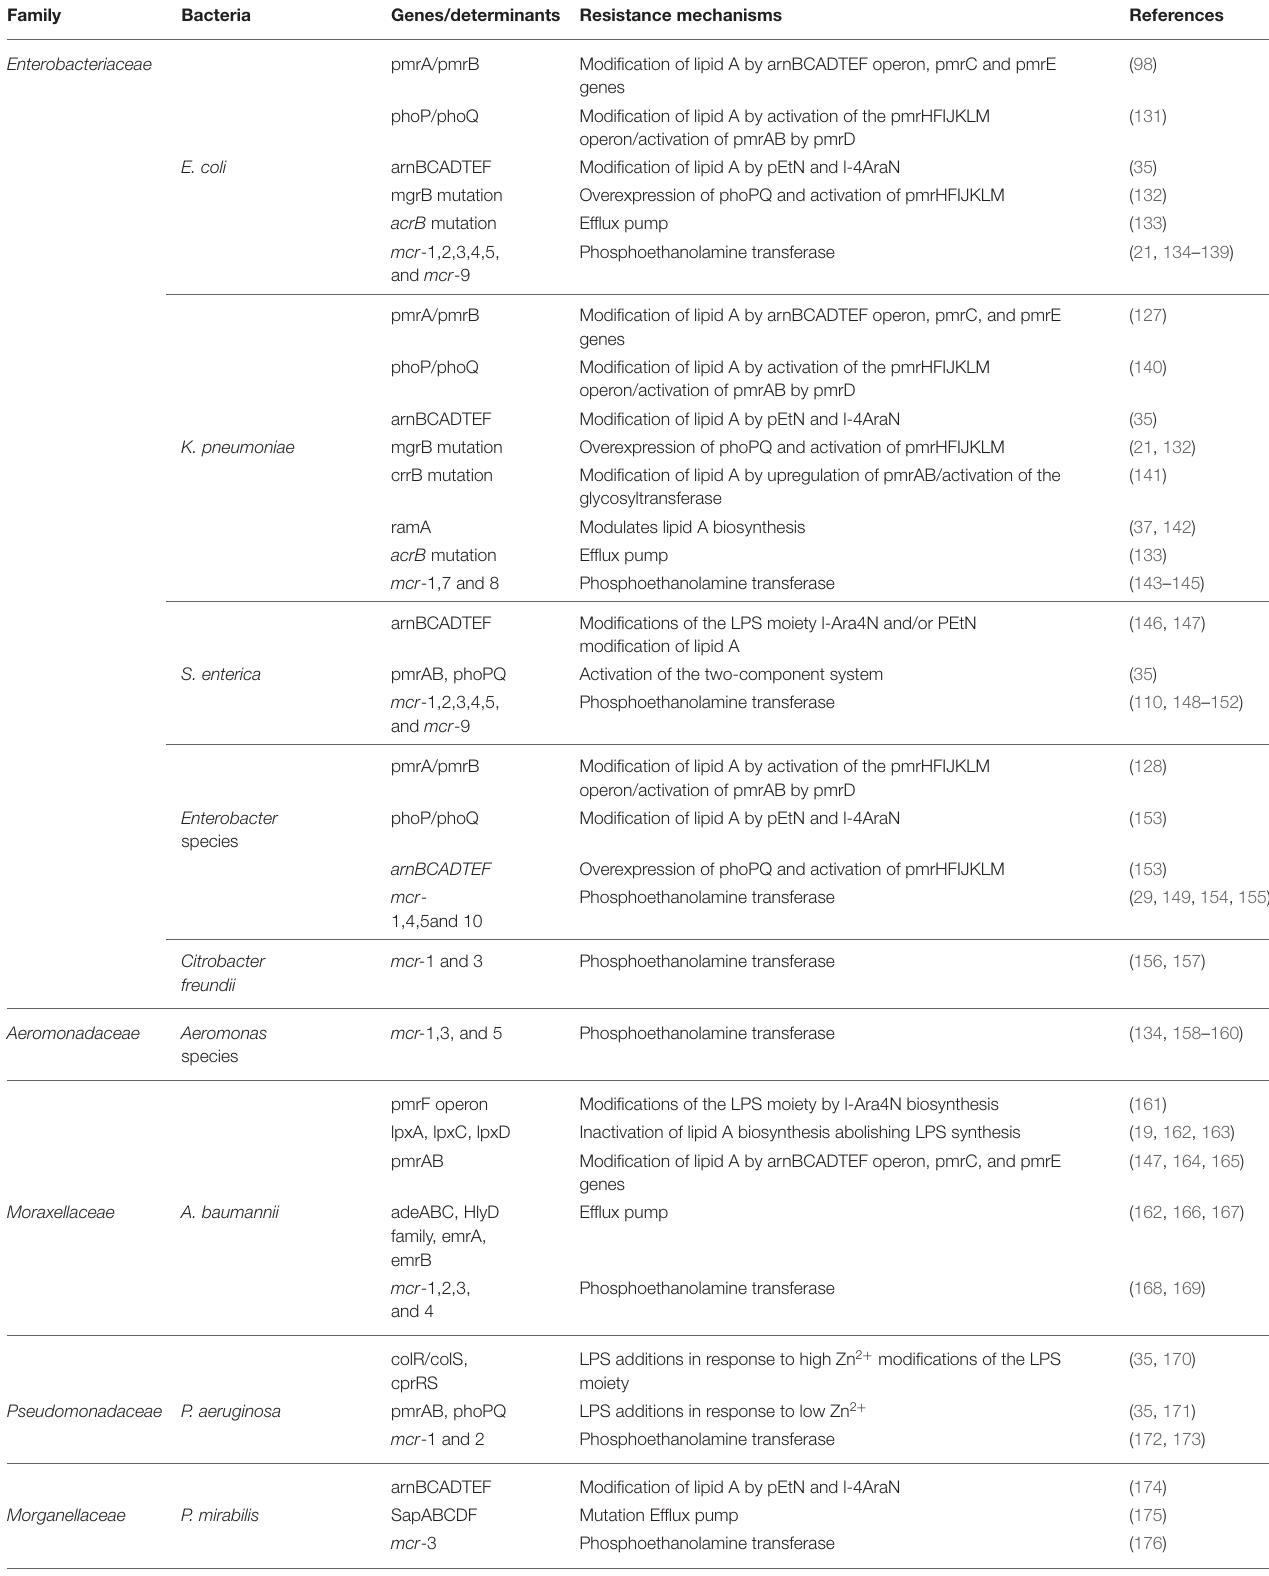
TABLE 1 | Characteristics of colistin resistance mechanisms and modifications associated with most known bacteria.